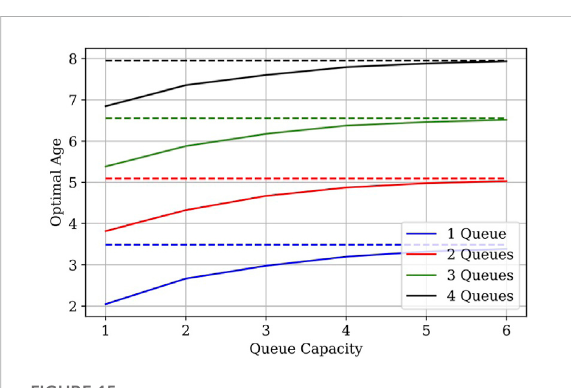
FIGURE 14 Optimal λ vs. queue capacity, μ = 1. The dotted line is the optimal λ for in fi nite capacity queues.